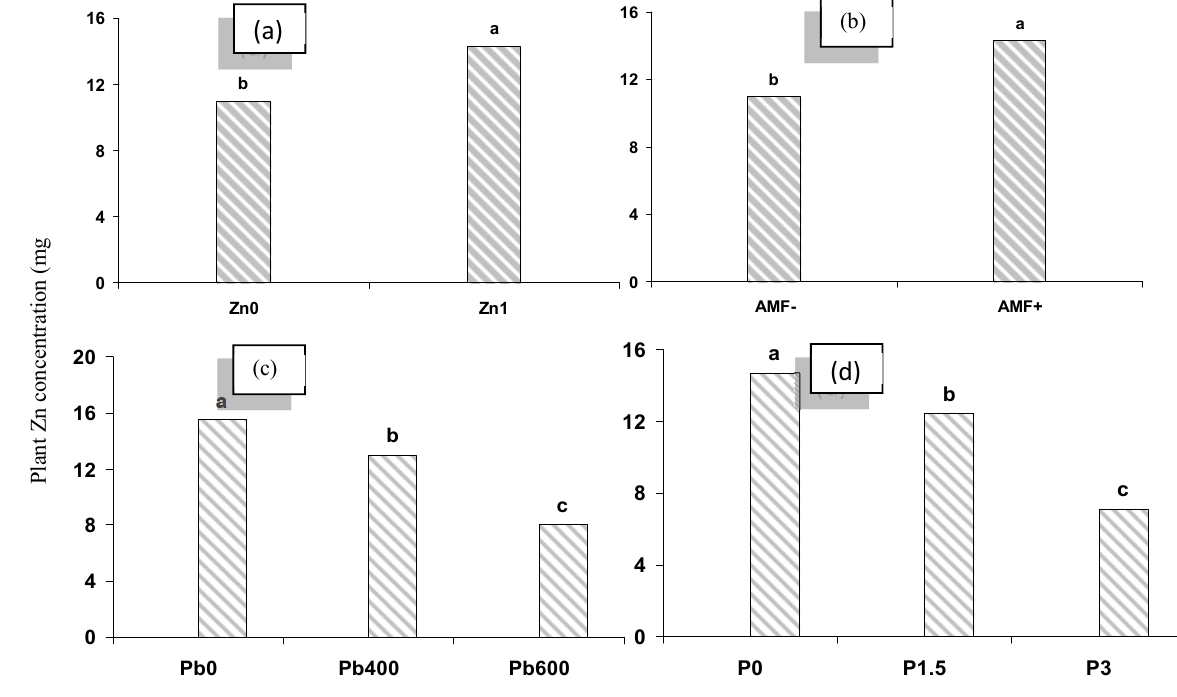
Fig. 1. The simple effect of ZnO nanoparticle (a), the presence or absence of AMF (b), Pb (c) and crude oil (d) pollution on plant Zn concentration. Pb 0 , Pb 400 and Pb 600 are 0, 400 and 600 mg Pb /kg soil, Zn 0 and Zn 1 are 0 and 1 % (W/W) ZnO nanoparticle, AMF - and AMF + indicate the presence and absence of arbuscular mycorrhiza fungus and P 0 , P 1.5 and P 3 are applying 0, 1.5 and 3 % (W/W) crude oil, respectively. Table 4. Effect of Zn oxide nanoparticles, Pb, and AMF on plant Zn concentration (mg/kg)